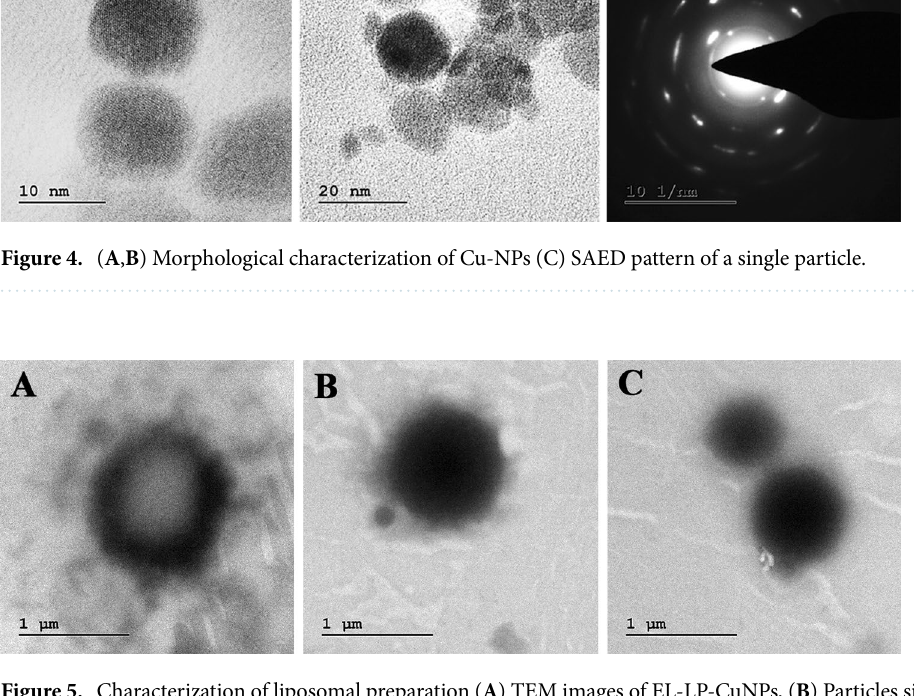
Figure 5. Characterization of liposomal preparation ( A ) TEM images of EL-LP-CuNPs, ( B ) Particles size confirmed by DLS analysis, ( C ) Zeta potential measurements of EL-LP-CuNPs.